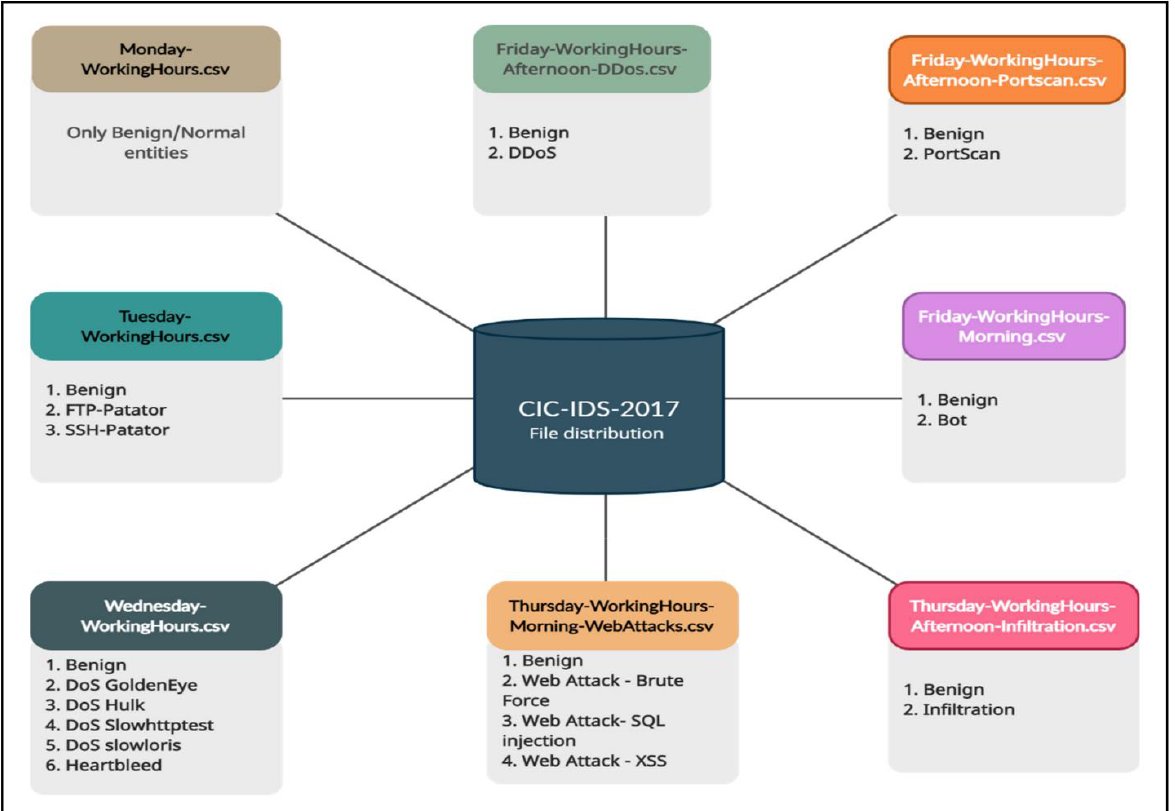
Figure 2. File distribution of the dataset CIC-IDS-2017.